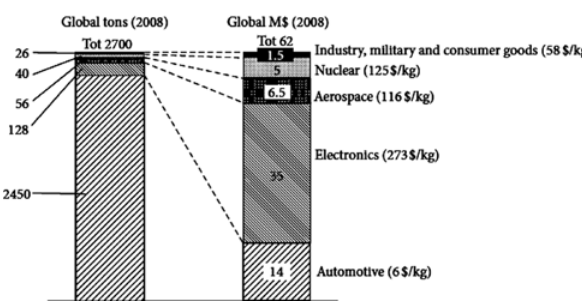
Figure 1: Distribution of mass and value of MMCs in the global market. Reproduced with permission from Hindawi Publications